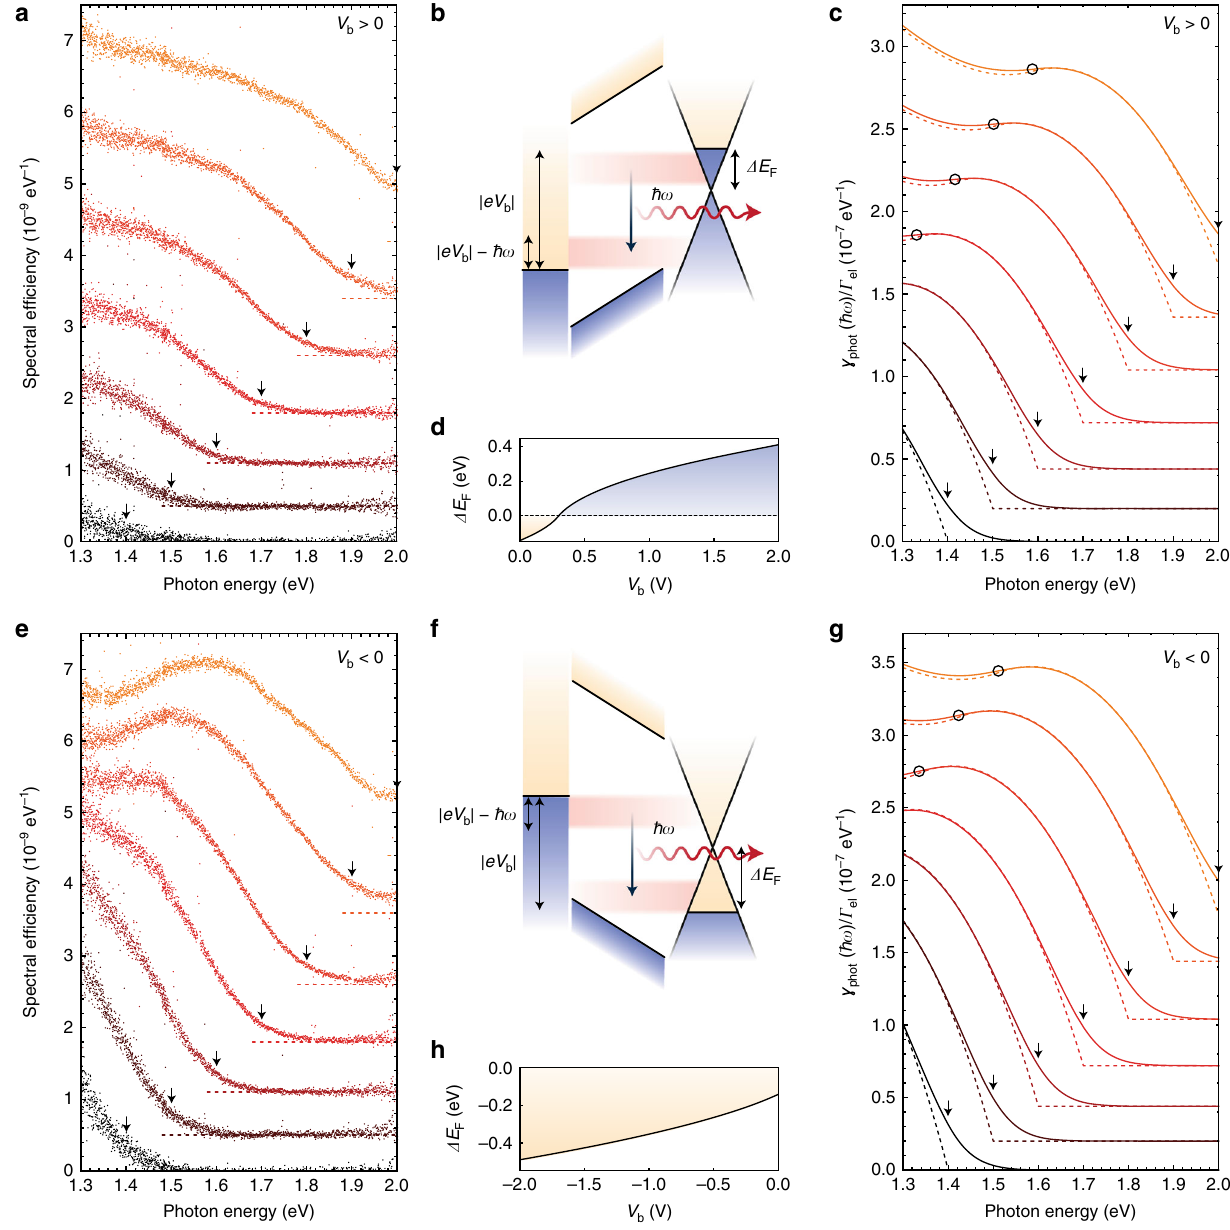
Fig. 4 Spectral distribution of directly emitted photons from vdWQT devices. a , e Measured ef fi ciency spectra (spectral distribution of emitted photons per tunneling electron, cf. Supplementary Note 1) for positive/negative voltages V b from a Au – 7L h-BN – Gr device. Subsequent spectra are acquired with increasing voltage from | V b | = 1.4 V (black) to | V b | = 2.0 V (orange) in steps of 0.1 V. Spectra are offset with respect to each other, dashed lines indicate the respective zero line. Arrows indicate the spectral position where ħ ω = eV b . b , f Schematic of inelastic electron tunneling at positive/negative voltages. Optical mode excitations (here: photons) are generated by spontaneous transitions from occupied states in one electrode to unoccupied states in the other electrode. The energy window available for spontaneous excitation of a mode of energy ħ ω is given by | eV b | − ħ ω . c , g Theoretical photon emission rate spectra ( ρ rad = 0.04 ρ 0 ) for positive/negative voltages V b , normalized to the elastic tunneling rate Γ el . Spectra are calculated for voltages from | V b | = 1.4 V to | V b | = 2.0 V in steps of 0.1 V. Straight and dashed lines show calculations for T = 300 K and T = 0 K, respectively. Black circles mark the positions on each curve for which the condition | eV b | − ħ ω = | Δ E F | is ful fi lled. Arrows indicate the spectral position where ħ ω = eV b . d , h Electrostatically induced graphene Fermi level shift Δ E F (cf. Methods) as a function of (positive/negative) applied emission is radially polarized. Experimentally, this distribution is obtained by imaging the back focal plane of the microscope objective that collects the photons. The measured radiation pattern, as well as the decomposition into two orthogonal polarization directions, is shown in Fig. 3b – d. The experimental results stand in excellent agreement with the direct emission mechanism.